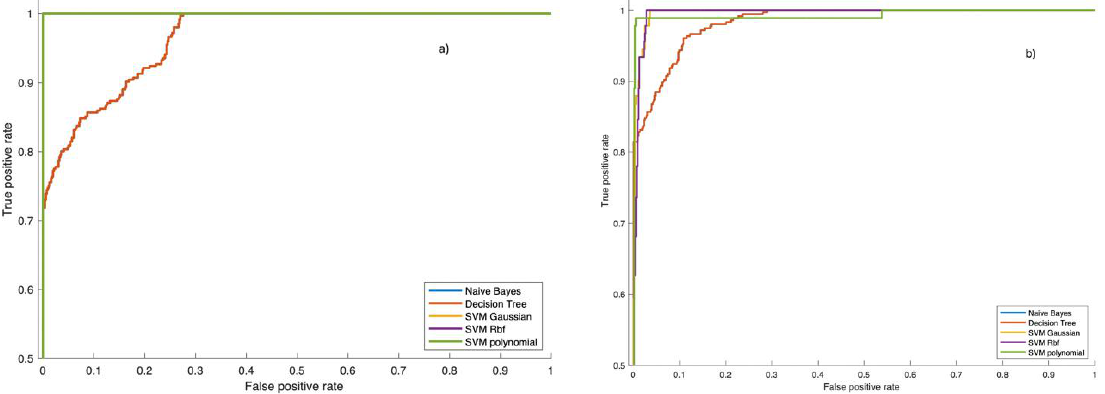
Figure 4. Area under the receiver operating characteristic (AUC) curve: ( a ) texture with image adjustment, ( b ) gamma correction at gamma value of 0.04 to distinguish the NSCLC from SCLC.